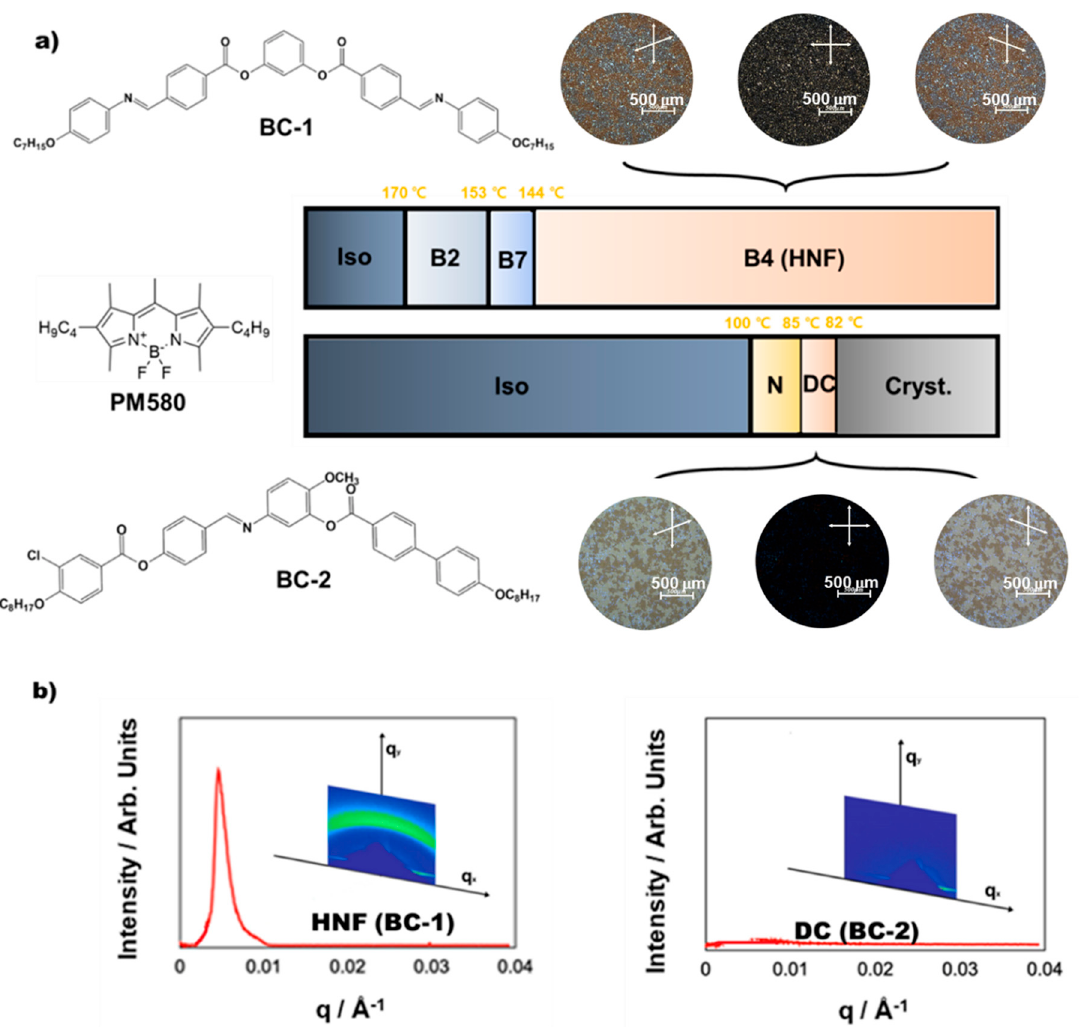
Figure 2. ( a ) Molecular structures, phase sequences (as determined during cooling), and typical POM images of two enantiomeric domains in the B4 (HNF) phase (BC-1) and DC phase (BC-2). The molecular structure of the PM580 luminescent dye is also depicted. ( b ) Carbon K-edge 2D RSoXS patterns of HNF (BC-1) and DC (BC-2) and their 1D profiles plotted on q . The triangular object in the 2D pattern is a projection of the dumper blocking the direct beam.